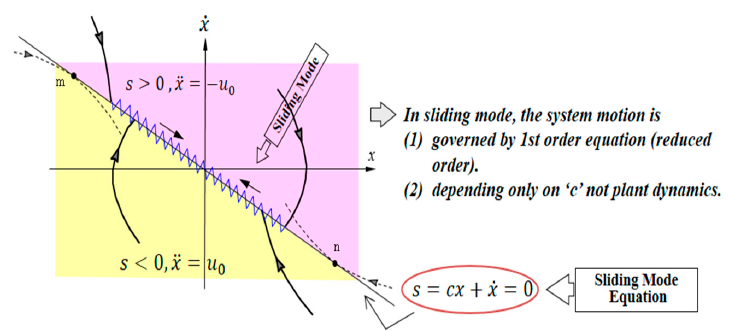
Figure 9. Schematic representation of sliding mode control scheme [28].